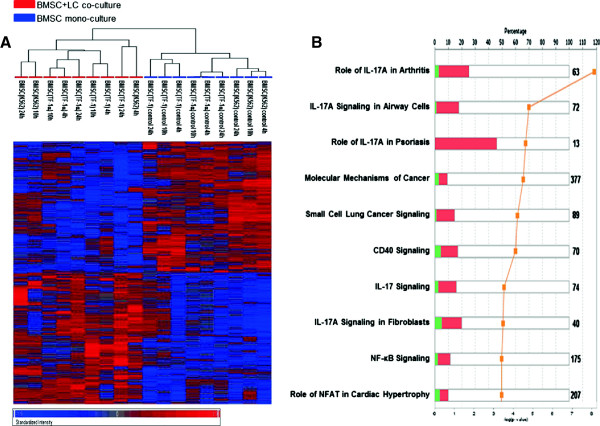
Gene expression analysis of BMSCs co-cultured with leukemia cells compared with BMSC mono-cultures shows changes in IL-17 signaling-related genes. (A) Hierarchical clustering analysis of 1540 differentially expressed genes in BMSCs co-cultured in transwells with three leukemia cell lines (TF-1, TF-1α and K562) compared with BMSC mono-cultures (control) using Partek Genomic Suite program (ANOVA test with unadjusted p-value < 0.05). The displayed colors represent the fold changes where shades of red and blue indicate up- and down-regulation respectively. The color key for the sample labels is on the top left. (B) Ingenuity Pathway Analysis (IPA) of the 1540 differentially expressed BMSC genes. Numerical symbols at the right side of each bar indicate the total number of genes composing the pathway. The bars indicate the percentage of up- (red bar) and down-regulated (green bar) genes in each pathway, while the orange line indicates minus-log transformed p-value. The top 10 canonical pathways are shown.